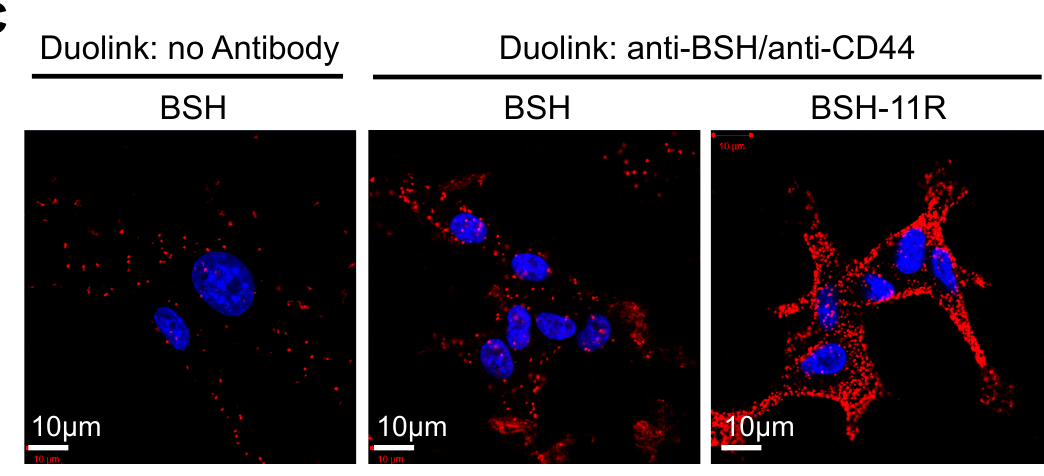
Figure 3. BSH-polyR directly interacted with the CD44 cell-surface molecule. ( A ) The immunoprecipitation experiment was performed with a mixture of the cell lysate of MDA-MB-231 and BSH compounds. Anti-BSH antibodysuccessfullyprecipitatedtheCD44moleculefromBSH-11R-addedsamples,whileitfailedtoprecipitate CD44 from the BSH-added samples. ( B ) The 10 B concentration of immunoprecipitates was measured using inductively coupled plasma-atomic emission spectrometry (ICP-AES). The cell lysate of MDA-MB-231 was mixed with BSH compounds and immunoprecipitated with anti-CD44 antibody. ( C ) The Duolink assay identified the in situ interaction of BSH-11R and